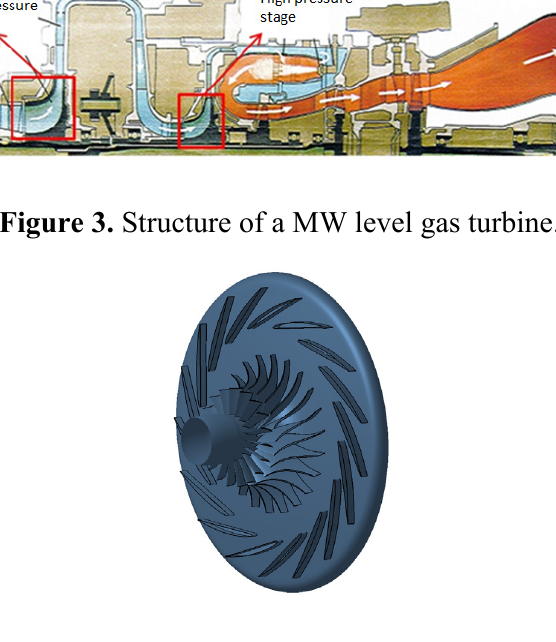
Figure 4. Geometric structure of a low stage centrifugal